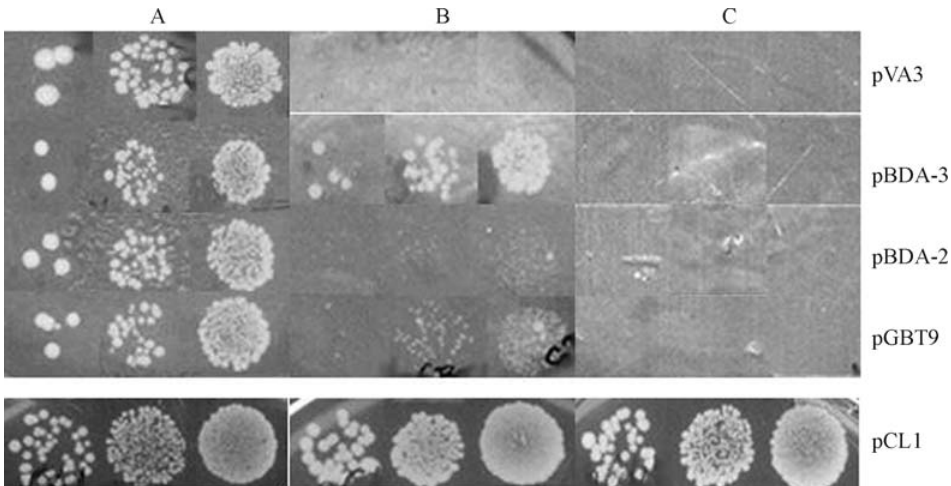
Figure 1 - Transcriptional activation in 3-AT assay. HF7c transformant cultures carrying plasmids pVA3 (pGBT9- p53 ), pBDA-3 ( GAL4-BD-mat A-3 ), pBDA-2( GAL4-BD-matA-2 ),pGBT9(vector)orpCL1(entire GAL4 ),werespotted,at10 -4 ,10 -3 and10 -2 dilutionsofastationaryculture,onSDmedium lacking: A) tryptophan (for pVA3, pBDA-3, pBDA-2 and pGBT9) or leucine (for pCL1), B) tryptophan and histidine or leucine and histidine and C) tryptophan and histidine or leucine and histidine and both enriched with 2.5 mM